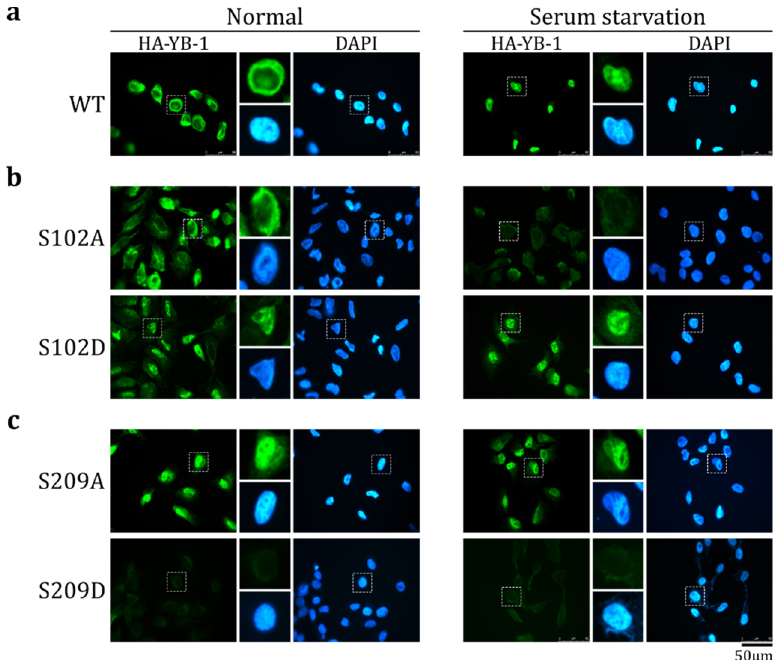
Figure 3. S209 phosphorylation inhibits YB-1 nuclear transport. Wild-type (WT) HA-YB-1 ( a ), HA- YB-1 S102A (( b ), upper panel), HA-YB-1 S102D (( b ), bottom panel), HA-YB-1 S209A ( c ), upper panel), and HA-YB-1 S209D (( c ), bottom panel) were tested in an in vitro transport system. HeLa cells were cultivated in normal ( left panel) and serum starvation ( right panel) conditions before permeabilization and to obtain cytosol. Localization of HA-YB-1 was analyzed by IF microscopy using anti-HA antibodies. Quantification of at least three independent replicates of the in vitro transport assay are shown in Figure S3.